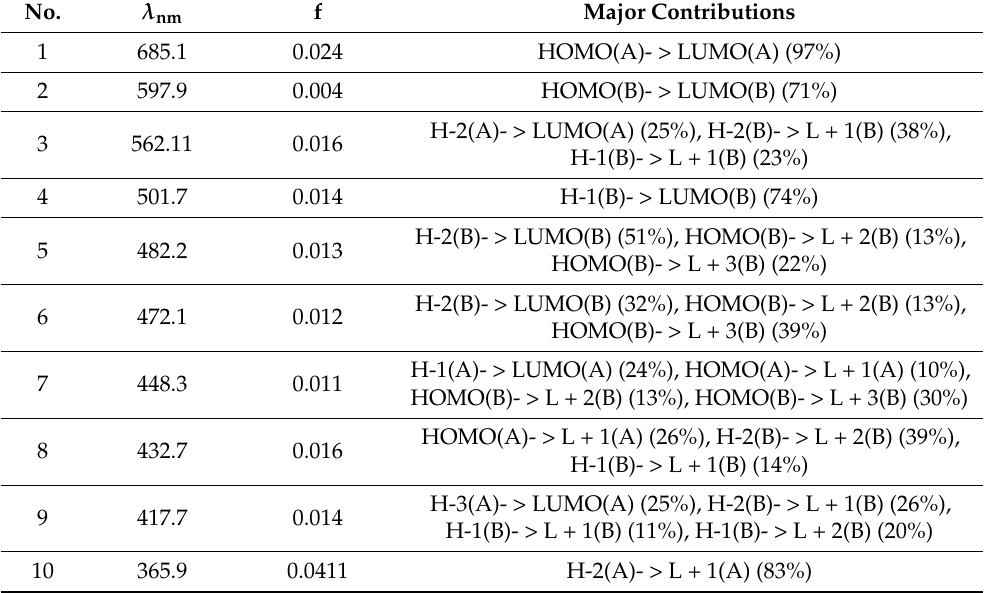
Table 2. Main TD-DFT bands with their